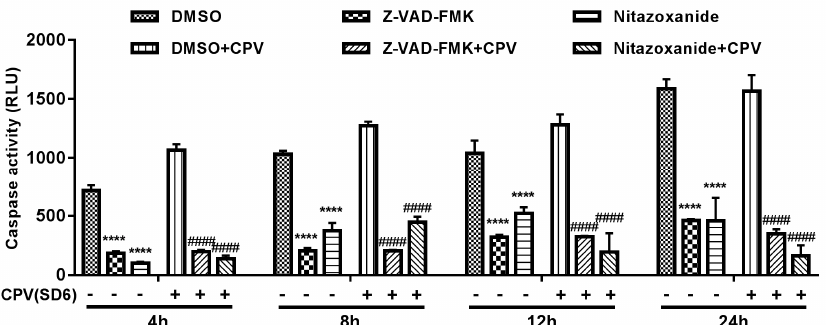
Figure 7. Caspase 3/7 activity of Nitazoxanide treated F81 cells. F81 cells were pretreated with 0.1% DMSO, Z-VAD-FMK (as a control to inhibit apoptosis), or Nitazoxanide for 1 h, then Caspase 3/7 activity of F81 cells with or without CPV infection were analyzed at 4 hpi, 8 hpi, 12 hpi, and 24 hpi. Statistical analysis was carried out using one-way ANOVA and Dunnett’s multiple comparisons test. * p < 0.05; ** p < 0.01; *** p < 0.005; **** p < 0.001 (compared to 0.1% DMSO-treated cells without CPV infection, at each time point). # p < 0.05; ## p < 0.01; ### p < 0.005; #### p < 0.001 (compared to 0.1% DMSO-treated cells with CPV infection, at each time